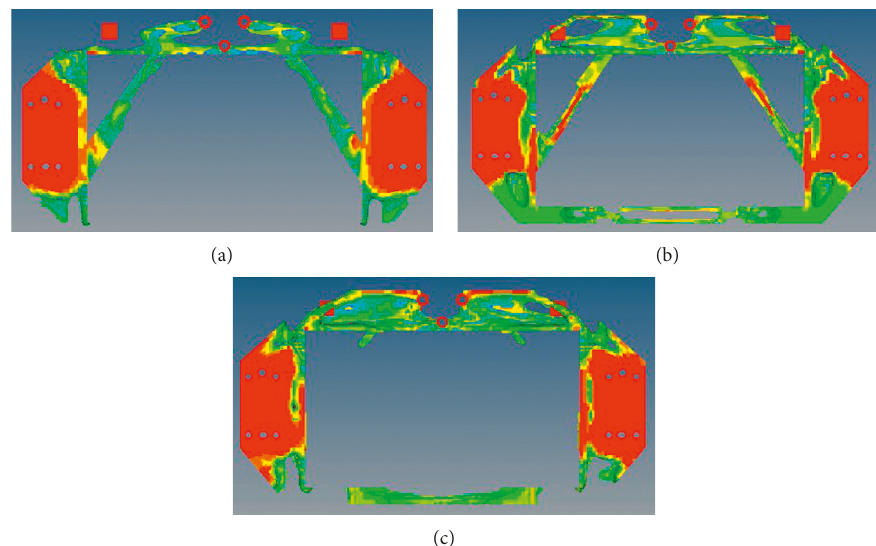
Figure 6: Results of dynamic load topology optimization. (a) First-order modal topology optimization results; (b) second-order topology optimization results; and (c) third-order modal topology optimization results.